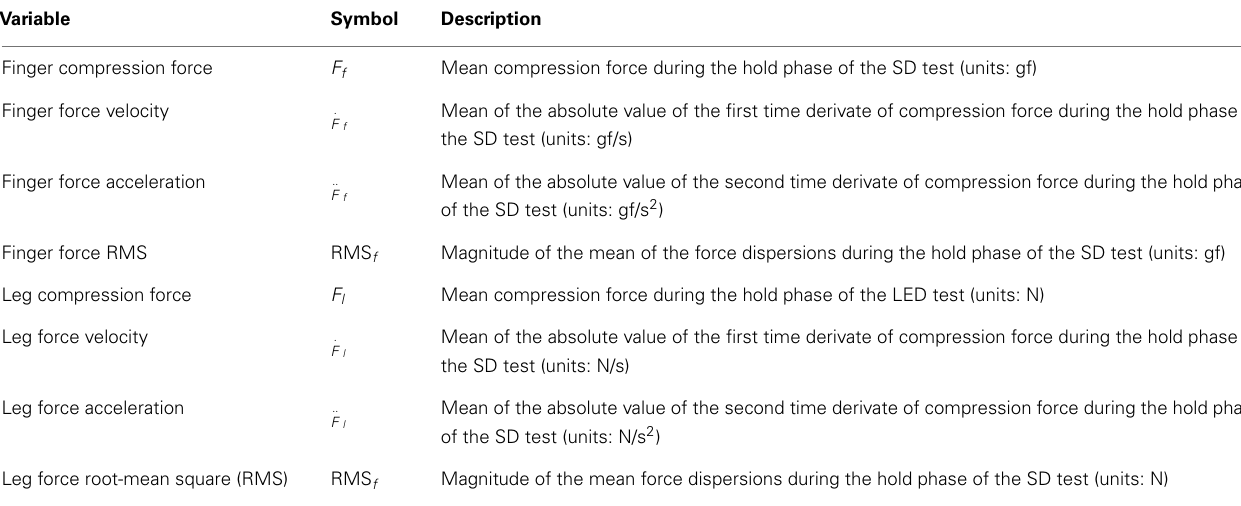
Table 1 | Definition of variables used in analyses .